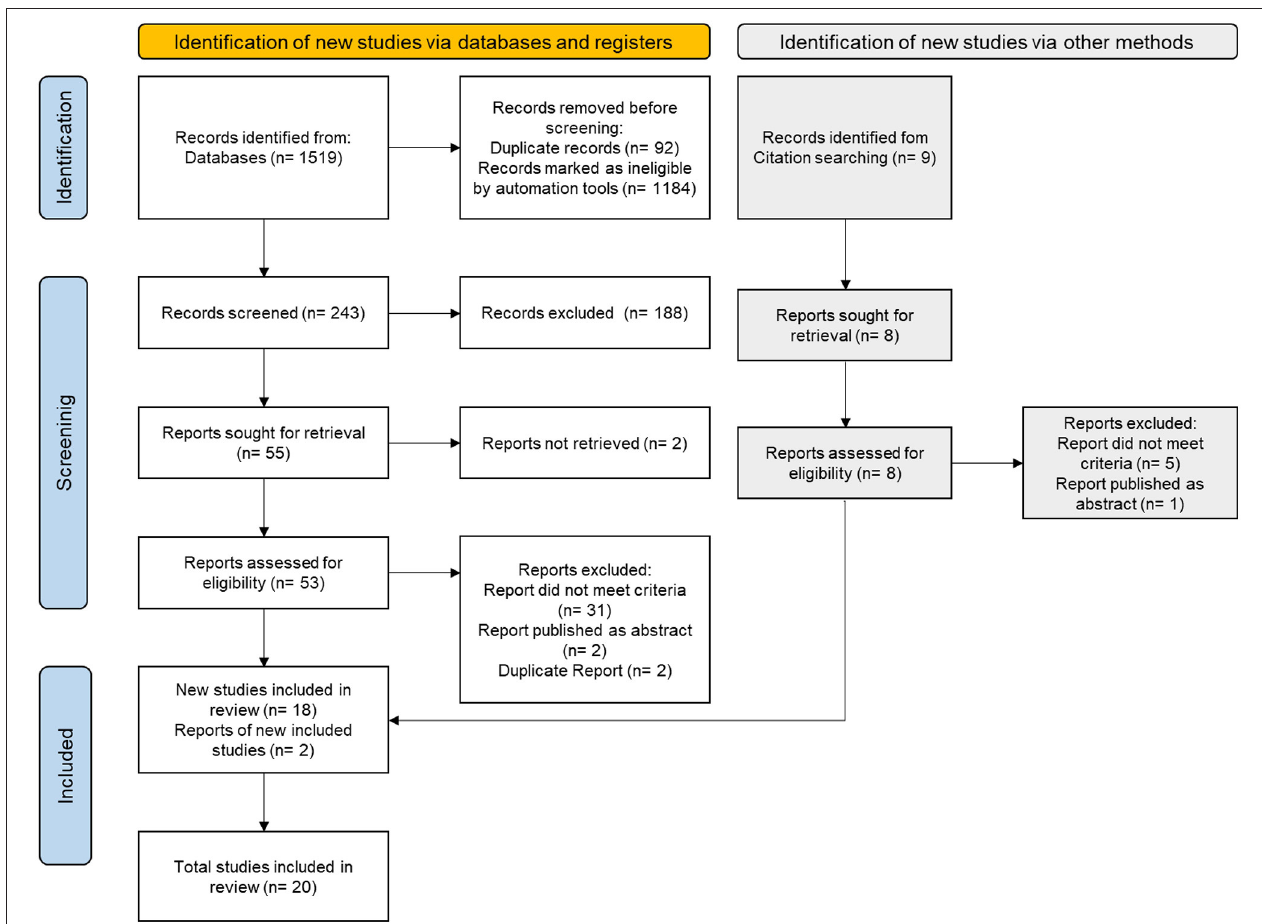
FIGURE 1 | Flow diagram of study